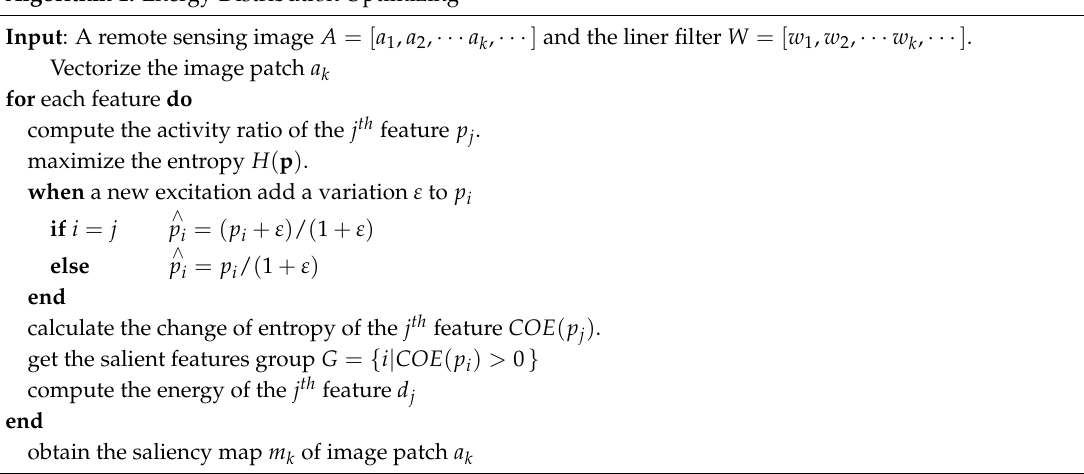
Algorithm 1. Energy Distribution